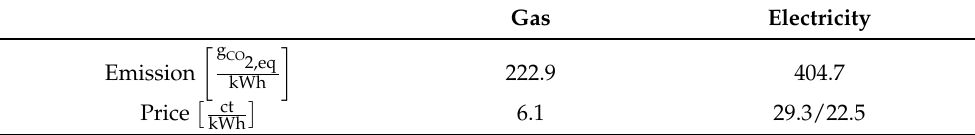
Table 3. Daily heat load